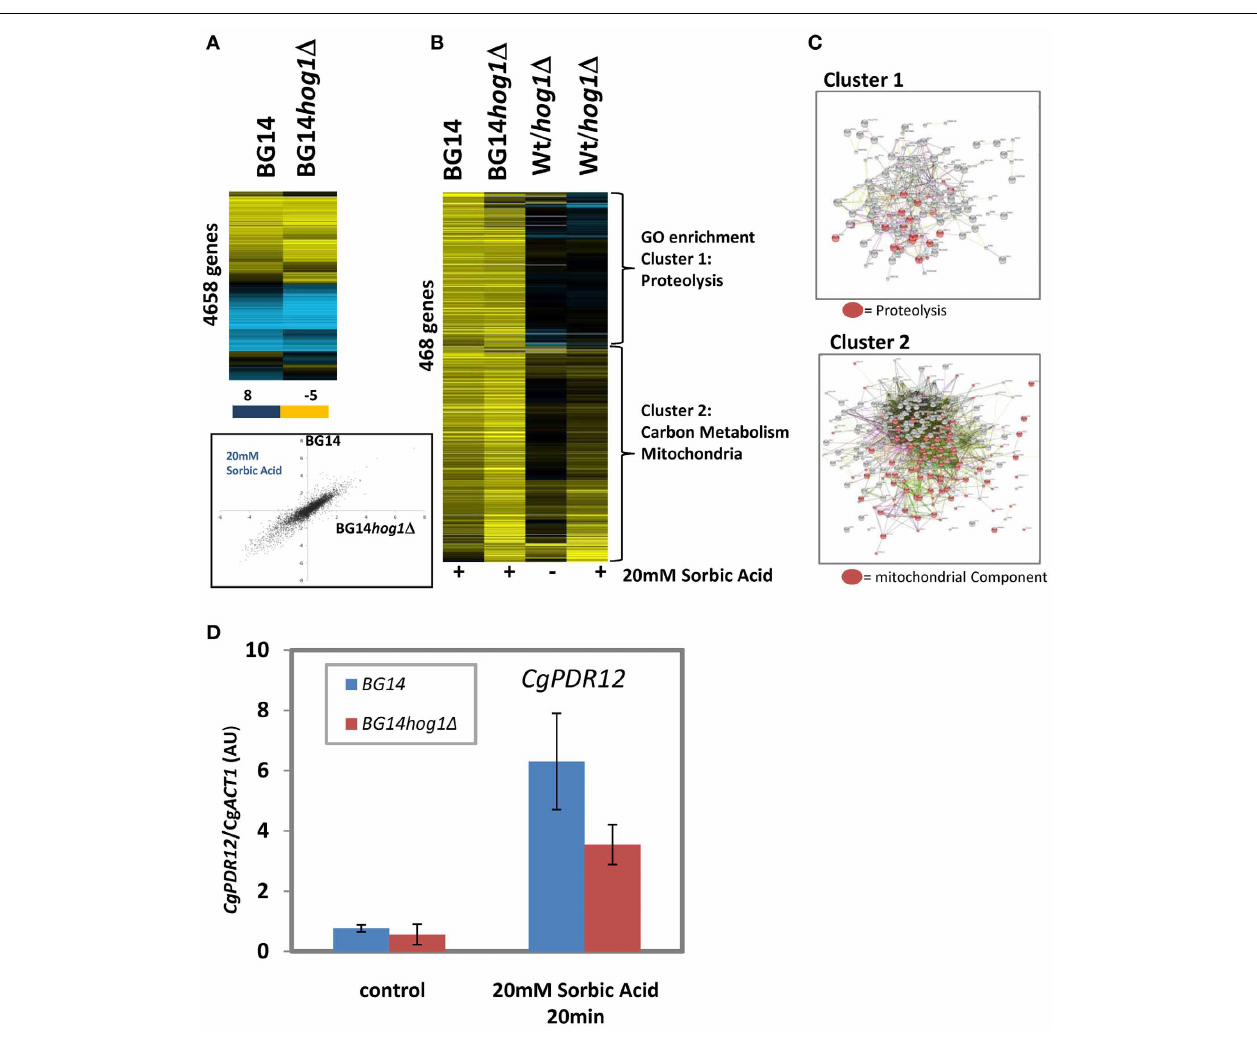
FIGURE 4 | Differentially expressed genes in BG14 and BG14 hog1 (cid:2) cells, treated with 20mM Sorbic acid for 20min. (A) Overall comparison of gene expression changes in wild type and mutant. Scatter Plot of sorbate treated wild type vs. sorbate treated hog1 (cid:2) . (B) Clustering of selected genes with